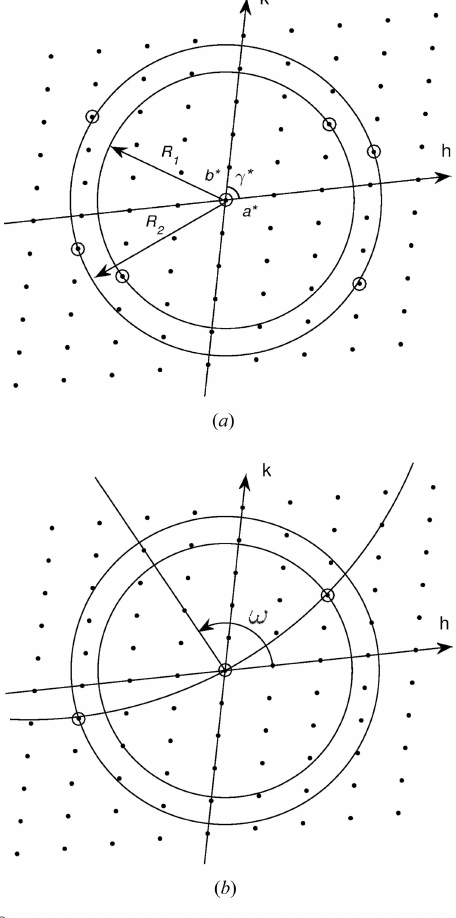
Figure 10 Illustration of the determination of ! for a pattern with two reflections. ( a ) The two observed peaks have radii R 1 and R 2 that correspond to one and two possible indexings (two and four indexings including their centrosymmetric mates) or reciprocal-lattice points, respectively. ( b ) Only one Ewald sphere section of radius cos( (cid:2) )/ (cid:3) (curved line) fits to one reciprocal-lattice point of radius R 1 and one of radius R 2 , within a tolerance T , which defines a unique !